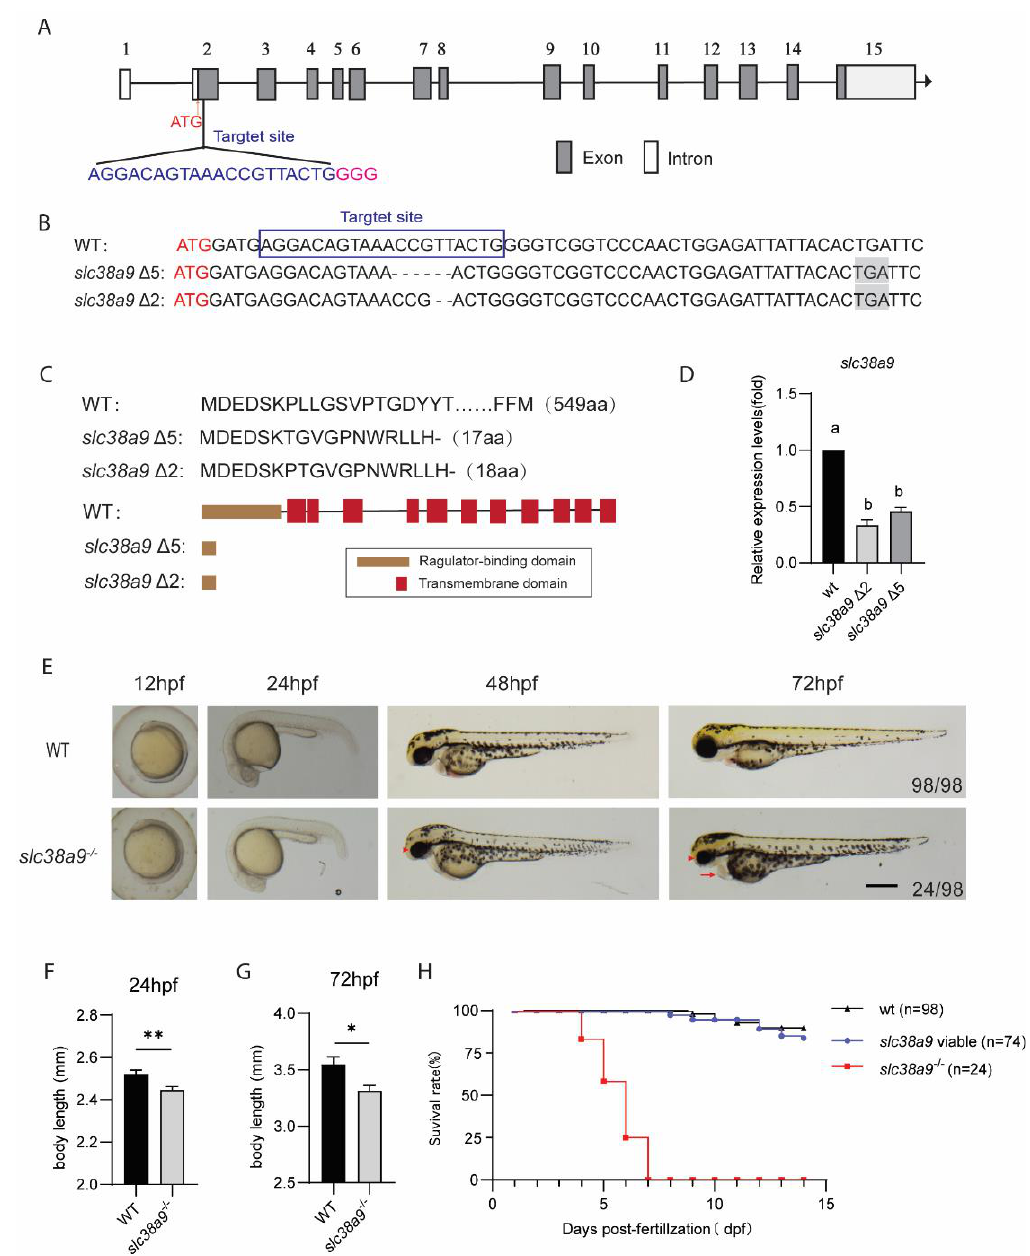
Figure 2. Knockout slc38a9 cause developmental defects in zebrafish. ( A ) Zebrafish slc38a9 gene structure. The selected Cas9 target sites sequence (blue) is in the second exon of the zebrafish slc38a9 gene. The PAM sequence is colored in pink. ( B ) The sequencing trace data of wild type and slc38a9 mutant alleles. The black shade is a premature stop codon. ( C ) The upper panel is the SLC38a9 protein sequences of WT and mutants. The lower panel is the schematic of the predicted SLC38A9 protein domains of WT and mutants. ( D ) Relative expression levels of slc38a9 mRNA in mutant and WT zebrafish at 3 dpf. The mRNA levels of slc38a9 were measured by qRT-PCR and normalized by β -actin mRNA levels. Data shown are mean ± SEM, n = 3. Different letters indicate significant differences at p < 0.05. ( E ) Live images of WT and mutant at the indicated developmental stage. The Arrowhead indicates the smaller eyes of the mutant, and arrow indicates the edematous pericardial cavity of the mutant. Scale bar = 500 μm. ( F , G ) The body length of mutant zebrafish was shorter than WT at 24 and 72 hpf. Data shown are mean ± SEM, n = 10. * p < 0.05, ** p < 0.01. ( H ) Viability of wild type and slc38a9 mutant larvae.